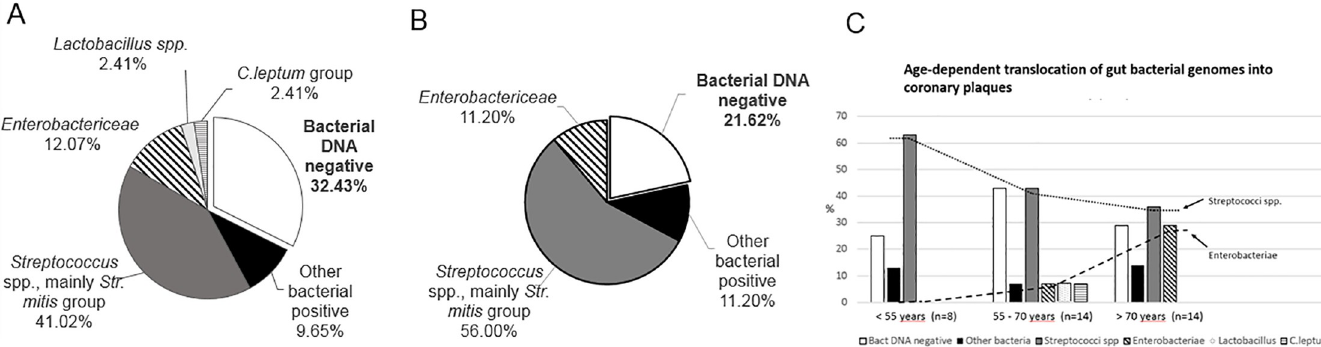
Fig 2. Gut bacterial translocation and bacterial DNA positivity in coronary plaques (n = 37). 2A. Bacterial DNA detected in coronary artery samples (total n = 37) using specific primers and probes for Bacteroides spp., Clostridium (C . ) leptum group, Clostridium coccoides group, Bifidobacterium spp., Enterobactericeae , Lactobacillus spp., and Streptococcus spp. in all samples. The total amount of gut bacteria was measured using universal bacterial primers and probe described in Tuomisto et al., 2014 [25]. 2B. Bacterial DNA detected in coronary artery samples of CHD samples. 2C. Age-dependent translocation of gut bacteria into plaques.